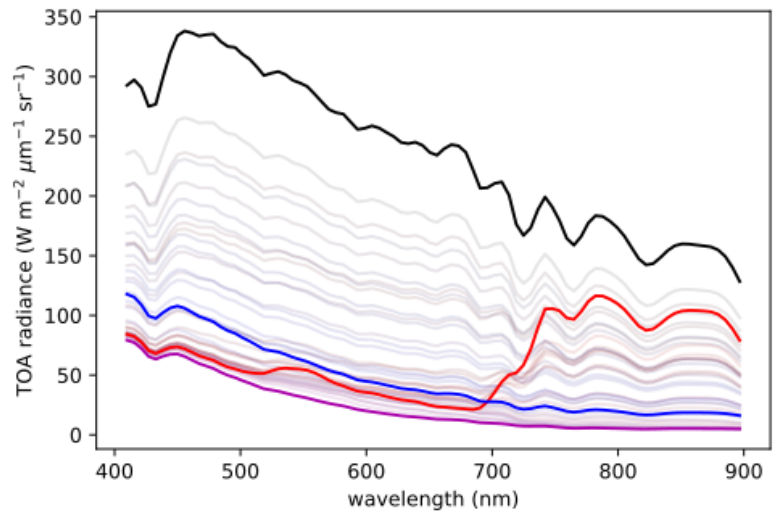
Figure 6. The spectra of every fourth node along each axis. The spectra in the corners are bold and colored black, red, purple, and blue (clockwise from the top left).